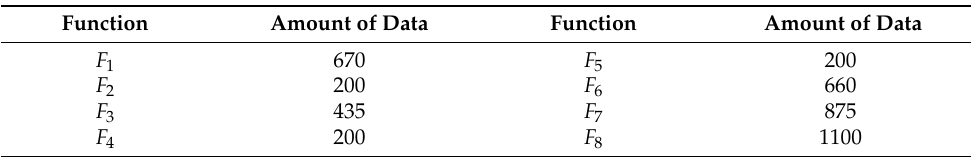
Table 1. Amount of data used for each Pareto optimal front. Function Amount of Data Function Amount of Data F 1